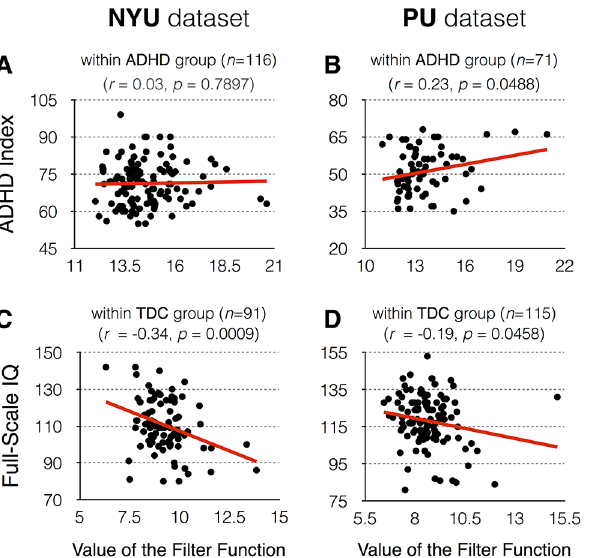
Fig 5. Scatter plots for the value of the filter function versus clinical phenotype variables. In the ADHD group, correlation coefficients with the ADHD index were evaluated for ( A ) the NYU dataset and ( B ) the PU dataset. In the TDC group, correlation coefficients with full-scale IQ were evaluated for ( C ) the NYU dataset and ( D ) PU dataset. doi:10.1371/journal.pone.0137296.g005 lowest values regarding demographic factors and ADHD symptom severity. The result shows that TDC subjects with higher values of the filter function consist of a younger age group (NYU dataset), contain more females (NYU dataset), have significantly lower IQ (NYU and PU datasets), and more severe hyperactivity/impulsivity (NYU dataset) compared to those with lower values of the filter function ( Table 4 ). Finally, the correlation analyses found a Table 4. Subgroup comparisons in demographics and clinical variables. Demographic and clinical